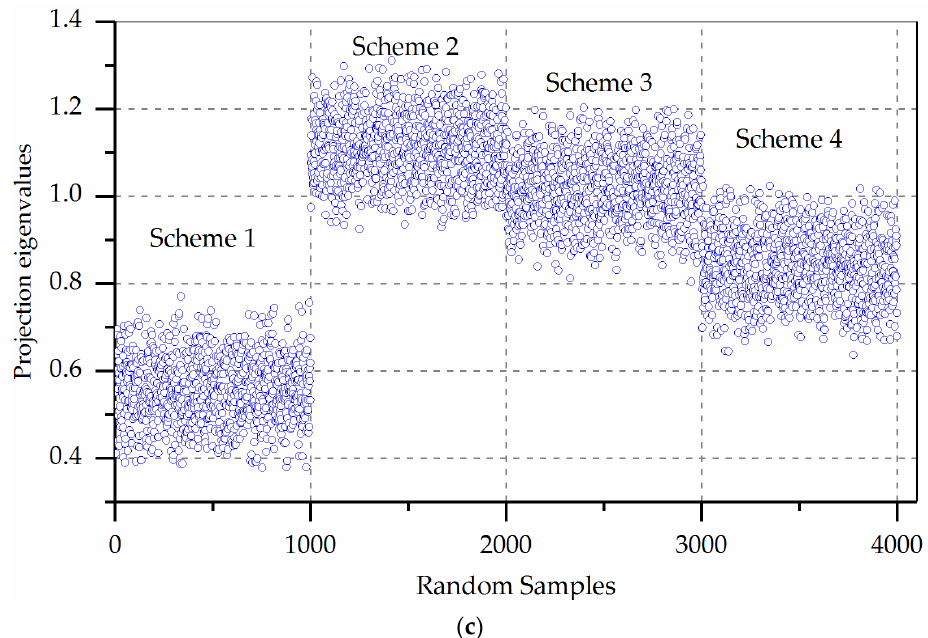
Figure 2. Scatter plot of projection eigenvalues of random samples for each scheme. ( a ) 10 random times results; ( b ) 100 random times results; and, ( c ) 1000 random times results.